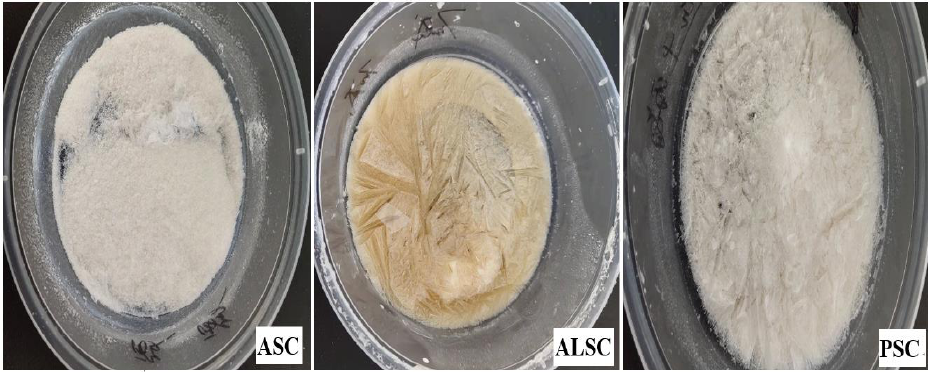
Figure 7. Effect of extraction method on the overall appearance of chicken bone collagen.